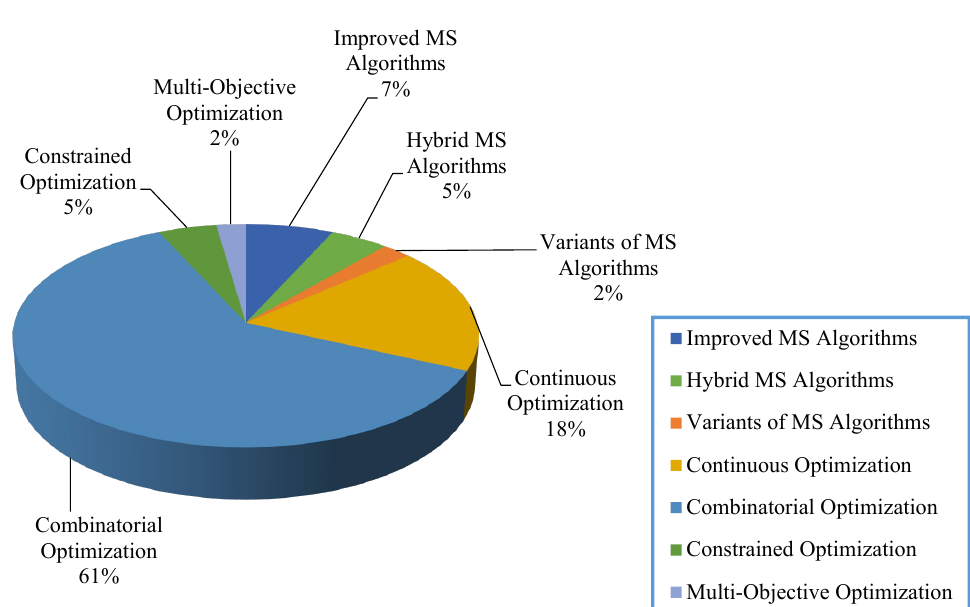
Figure 3. Classification proportions of MS. Table 1. Classification proportions for MS.